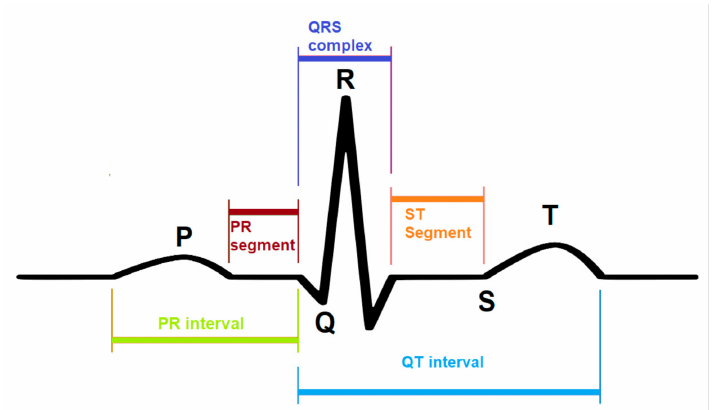
Figure 1. A model of an ECG signal. A different portion of the ECG signal is labeled to identify the functionality.